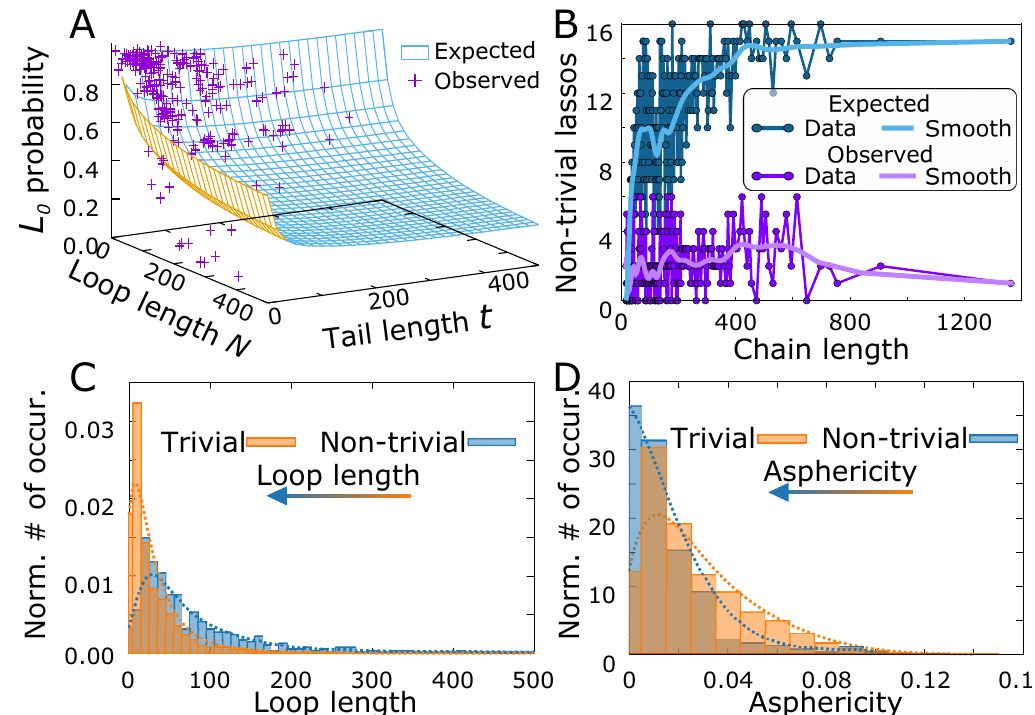
Figure 6. The complex lasso shapes in proteins. ( A ) The probability of trivial protein lasso versus the trivial lasso polymer surface, as a function of loop and tail length. ( B ) The expected and observed number of the non-trivial lassos as a function of the chain length. The light color curves show the smoothed traces. The normalized histogram of ( C ) loop lengths and ( D ) asphericity for the pierced and non-threaded (trivial) case. The arrows denote the shift of the distribution from trivial to the non-trivial case. The dotted lines denote the smoothed